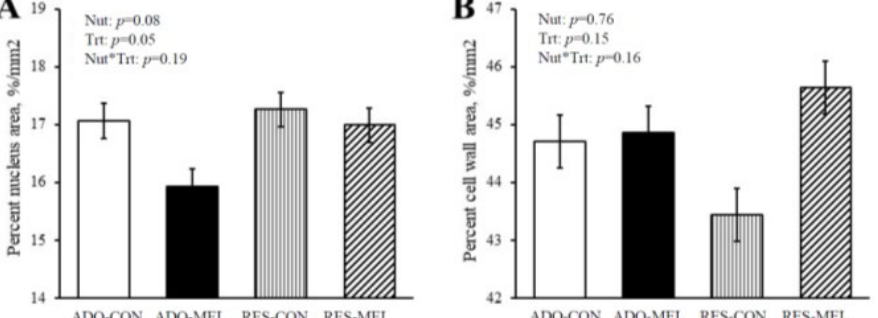
Figure 3. Percent area of nucleus ( A ) and Percent cell wall area ( B ) of 8-month-old fetuses. Values are means ± SE.